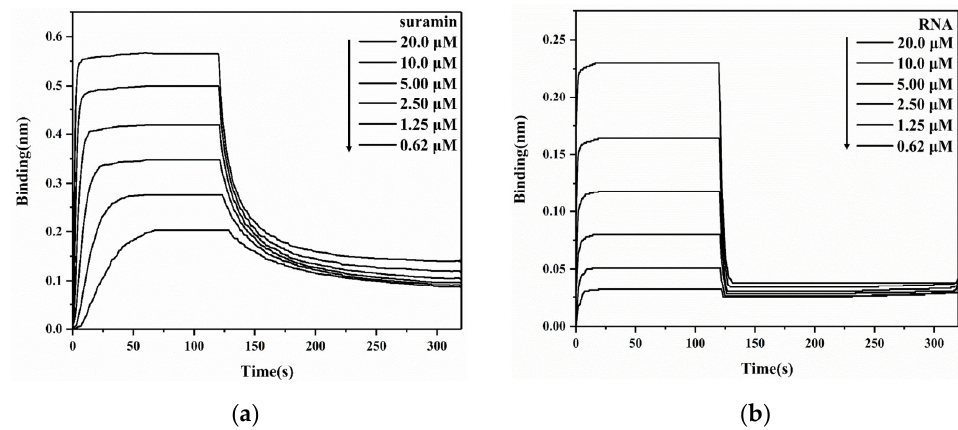
Figure 3. BLI experiments for detecting the interaction of SARS-CoV-2 N-NTD with suramin ( a ) or ssRNA-16 ( b ).